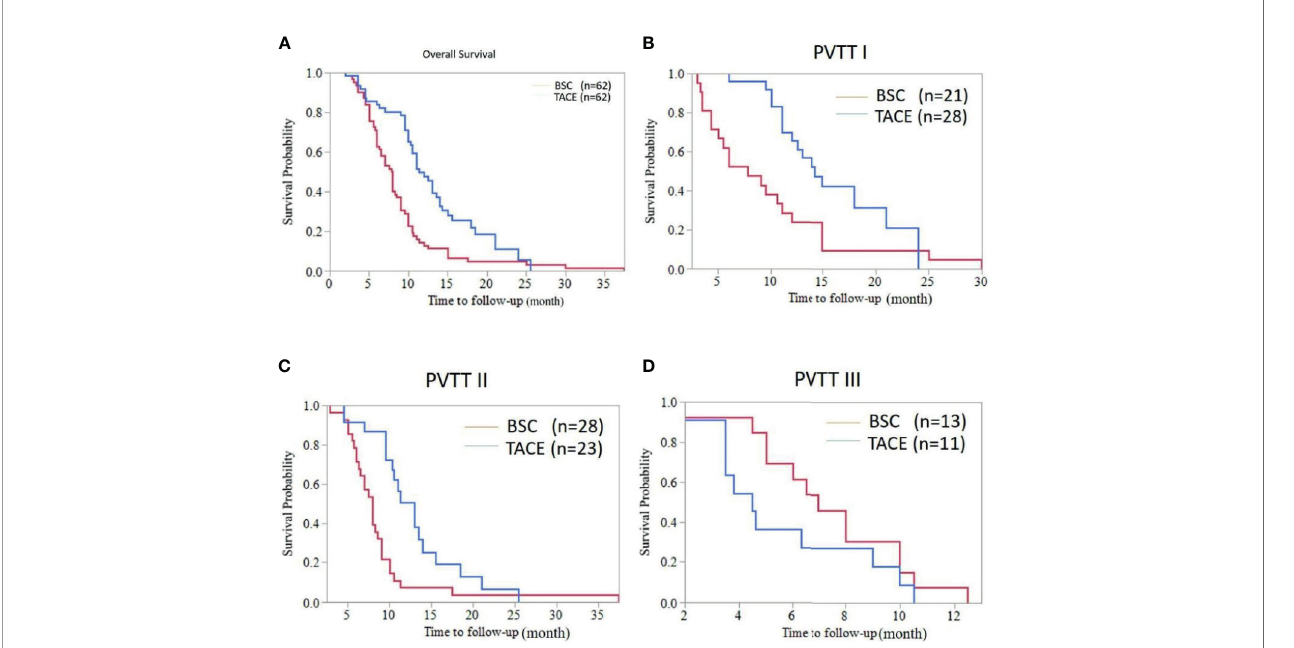
FIGURE 2 | Overall survival curve of HCC patients with PVTT accepting the TACE or BSC treatment. (A) Whole population survival curve for the TACE group and the BSC group (median OS [months], 11.30 (9.636-12.964) vs. 7.80 (6.748-8.852); P < 0.001). (B) Survival curve of HCC patients with type I PVTT in the TACE group and the BSC group (OS, 14.30 (11.492-17.108) vs. 7.80 (3.875-11.725); P =0.007). (C) Survival curve of HCC patients with type II PVTT in the TACE group and the BSC group (OS, 13.00 (10.539-15.461) vs. 8.00 (6.987-9.103); P =0.002). (D) Survival curve of HCC patients with type III PVTT in the TACE group and the